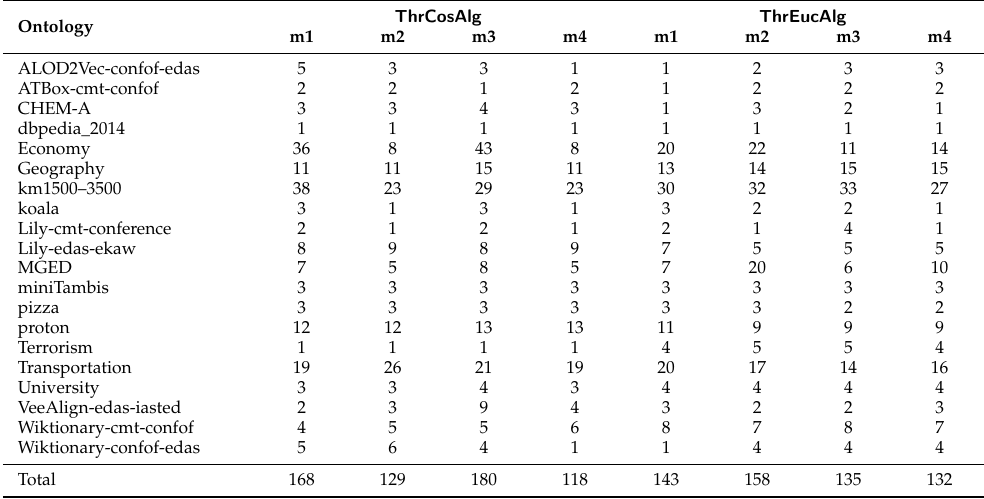
Table 6. Number of axioms removed by two threshold-based algorithms using different models.